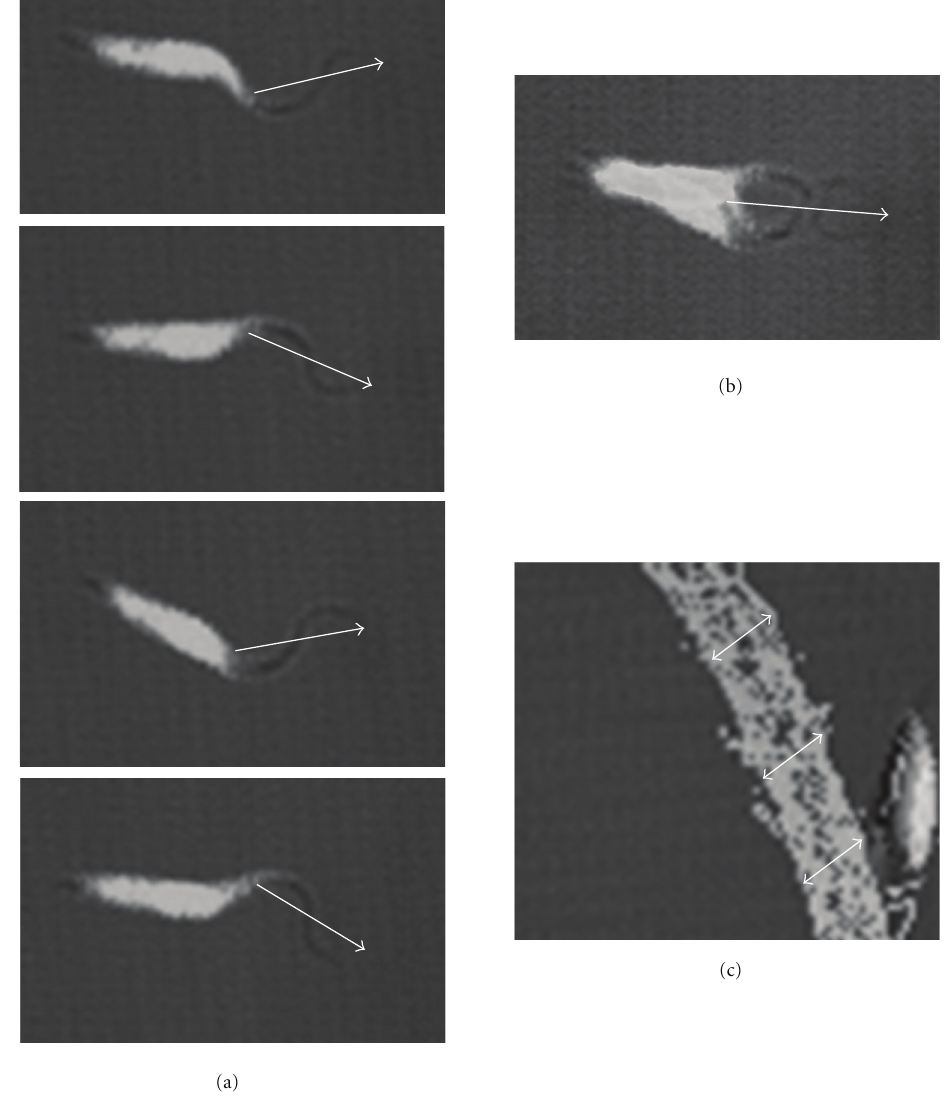
Figure 2: Analysis of the symmetrical flagellar beating of T. cruzi. (a) Parasite position and direction of motion (arrows) of four consecutive frames of an epimastigote with forward cell propulsion obtained from the green region of Figure 1. The amplitude and frequency of the flagellar wave were constant and symmetrical. (b) Fixed and superimposed images from panel a. (c) Plots of the movements and displacement of the epimastigote of panel (a). The arrows indicate the symmetry of parasite and flagellar wave contours during the cell displacement.